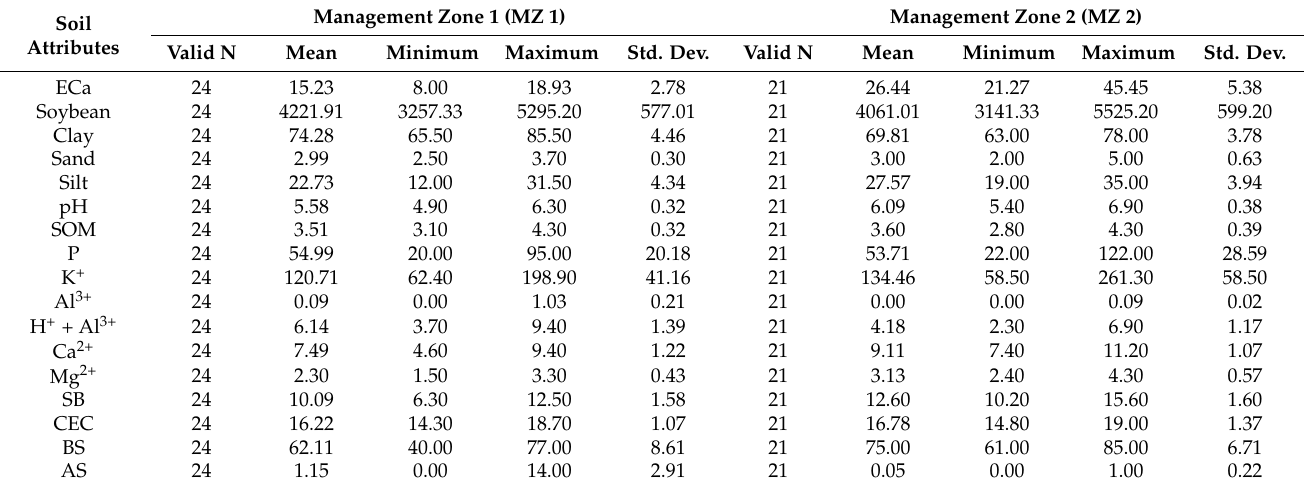
Table 3. Descriptive statistics of soybean yield and soil attributes for the clay area (Field C).